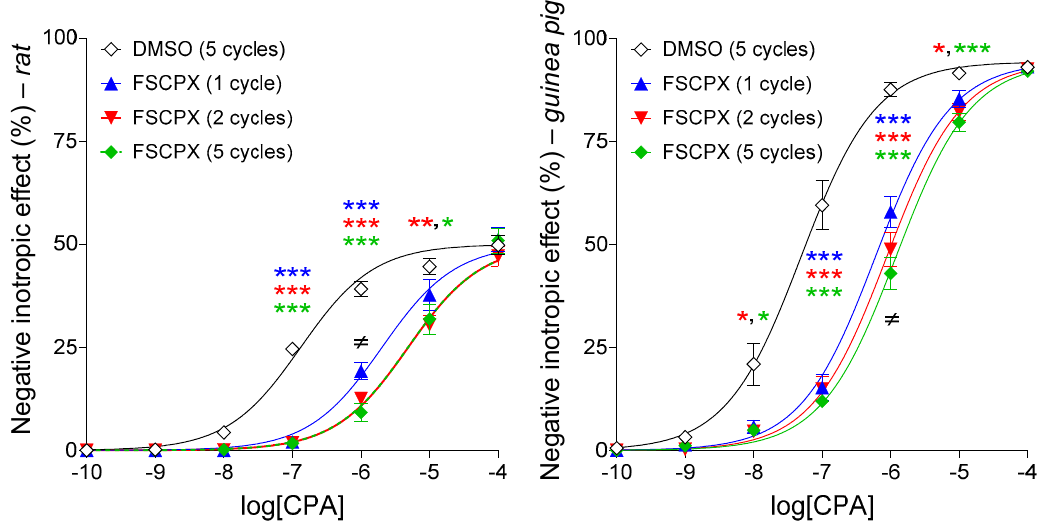
Figure 8. The direct negative inotropic effect of CPA in the isolated rat ( left panel ) and guinea pig ( right panel ) left atrium, with and without a pretreatment with 10 µ M of FSCPX (carried out three different ways). The x -axis denotes the common logarithm of the molar concentration of CPA (in the bathing medium), and the y -axis shows the effect (as a percentage decrease in the initial contractile force). The symbols indicate the responses to CPA averaged within the groups (± SEM), while the lines show the globally fitted Equation (1) (with shared E max and n parameters; see Table 2). The blue, red, and green E/c curves represent FSCPX pretreatments with one, two, and five administration(s) of FSCPX (each one preceded by a short wash-out), respectively, while the black E/c curve indicates the absence of an FSCPX pretreatment (but the presence of five administrations of DMSO, the solvent of FSCPX, preceded by five short wash-out periods). E/c: concentration–effect; FSCPX: 8-cyclopentyl- N 3 -[3-(4-(fluorosulfonyl)benzoyloxy)propyl]- N 1 -propylxanthine; DMSO: dimethyl-sulfoxide; CPA: N 6 -cyclopentyladenosine; *: comparison of the DMSO (five cycles) group with the three FSCPX-pretreated groups (the particular group is indicated by the color of the asterisk); ≠ : comparison of the FSCPX (1 cycle) group with the FSCPX (5 cycles) group (comparison of the FSCPX (2 cycles) group to other FSCPX-pretreated groups did not provide significant results); the number of marks refers to the level of statistical significance (one mark: p < 0.05, two marks: p < 0.01, three marks: p < 0.001).